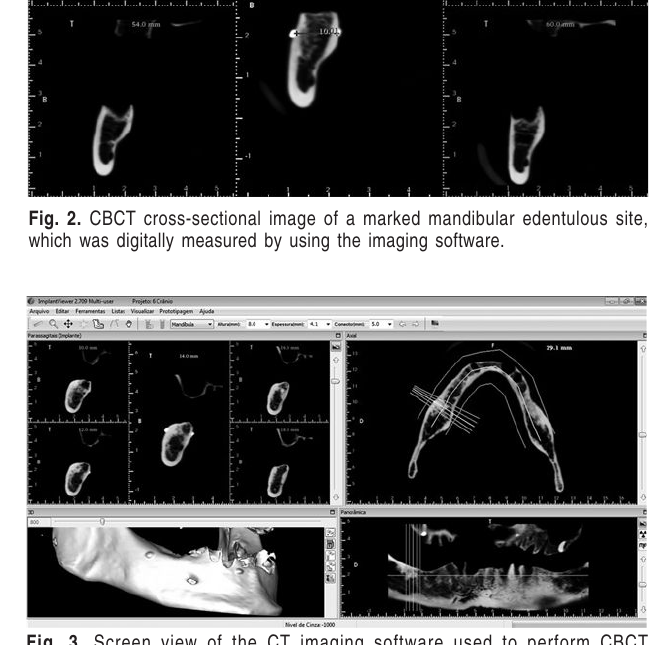
Fig. 3. Screen view of the CT imaging software used to perform CBCT measurements. All caliper, LT and CBCT measurements (in millimeters) were recorded separately in a random order by two trained independent observers. Measurement reproducibility